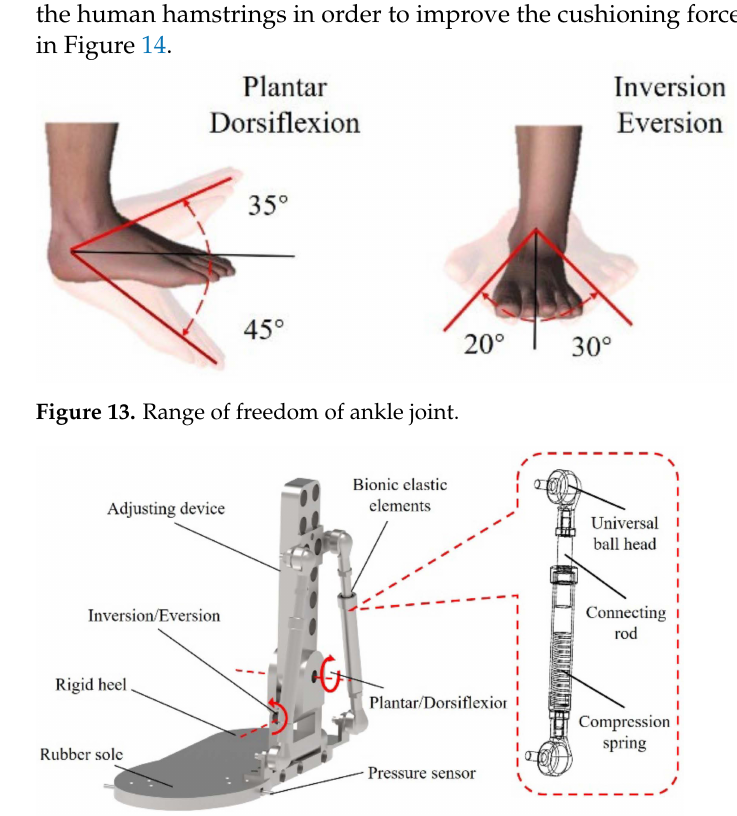
Figure 14. Ankle exoskeleton